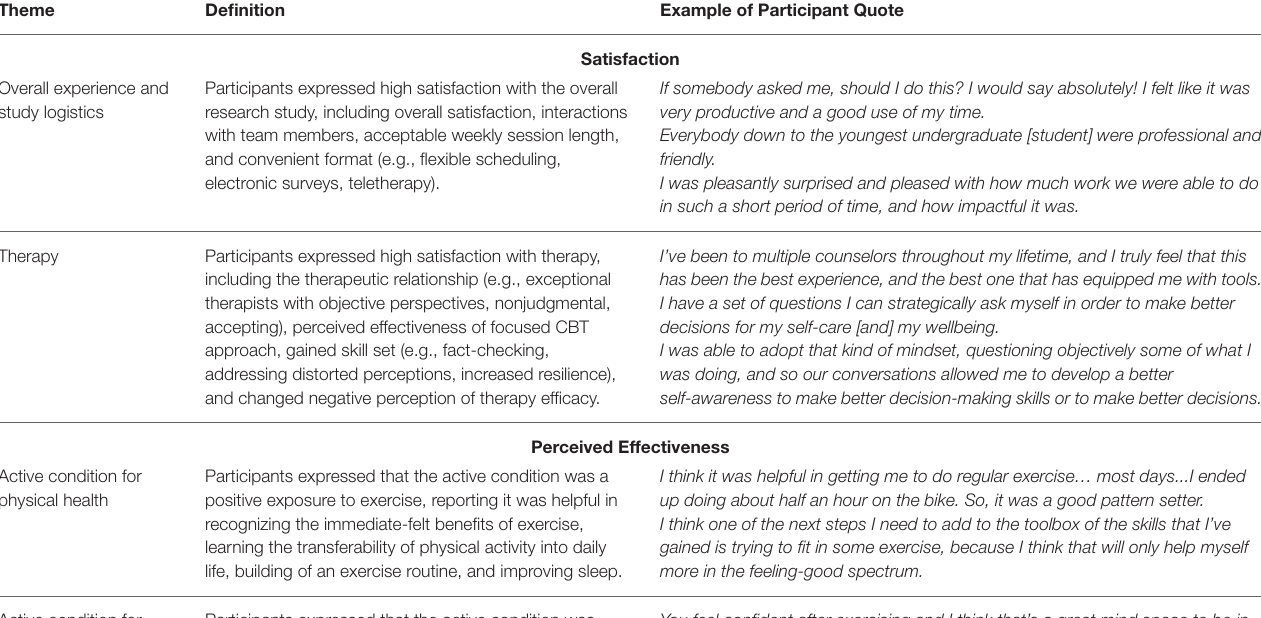
TABLE 3 | Thematic matrix of qualitative